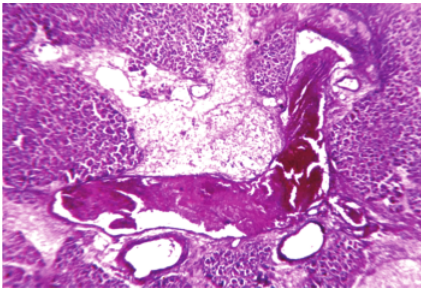
Figure 2: Focal necrosis of pancreatic parenchyma associated with massive thrombosis in venules. H&E ( × 40).